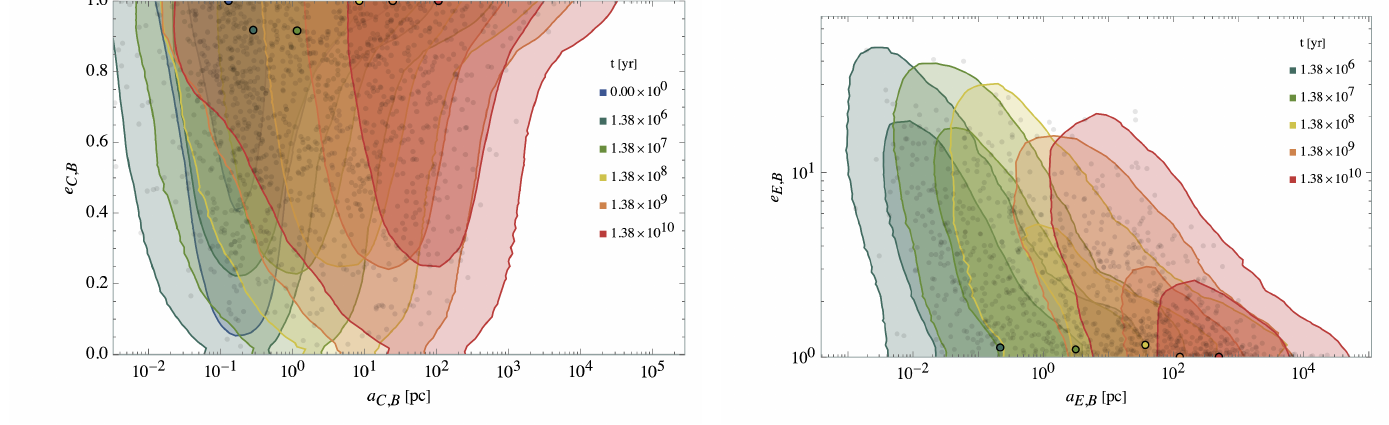
Figure 14. Shown are the 1 σ and 2 σ contours PBHs orbital eccentricity vs. semi-major axis segregated by population (cluster and ejecta) type at selected times, t BI = 2.64 × 10 5 yr plus the initial time-slice t 0 . All panels: Black dots show the scatter a 100 sample of individual PBHs in each time-slice, randomly selected in the case of the bare distribution and selected with a uniform probability distribution. The Best-Fit (BF) values of the distributions, marked by the large coloured dots in the plots, are given in Table